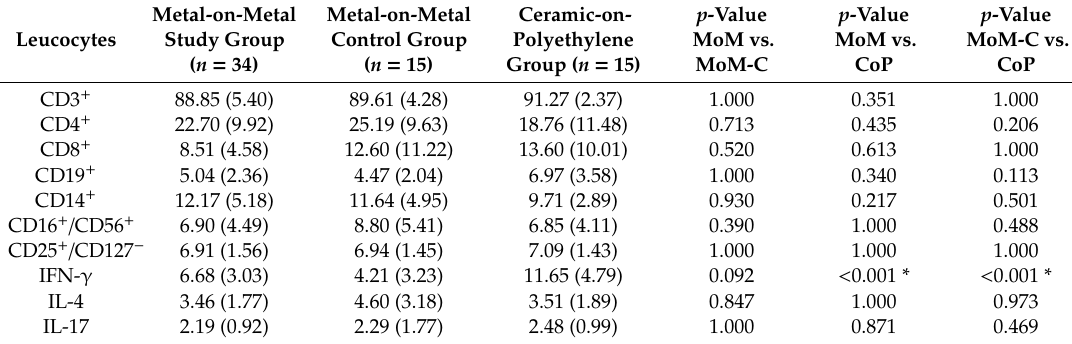
Table 4. Summary of leucocyte cell counts of the study and the control groups (the values are given in percentages, as frequency of parents).